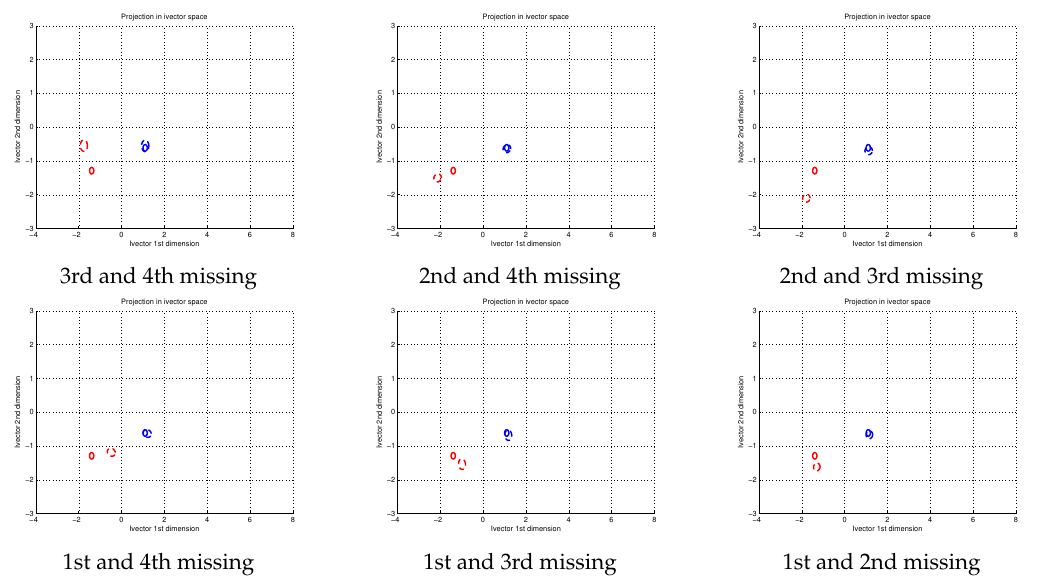
Figure 4. Comparison of posterior distribution of i-vectors when two phonemes are not contributing and α i =